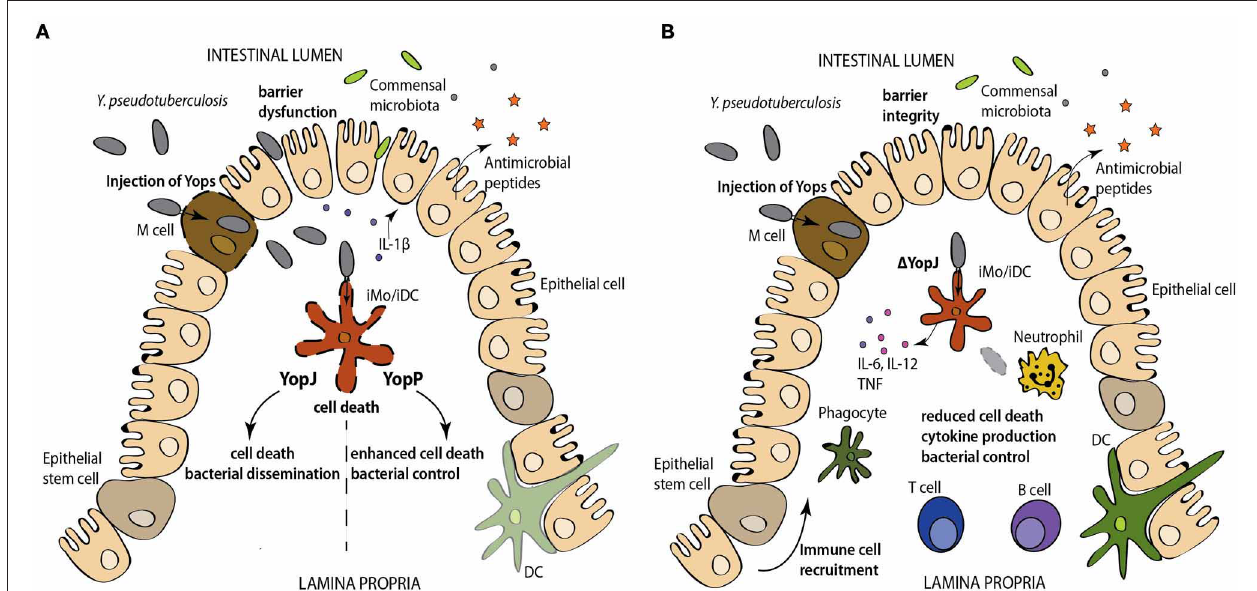
FIGURE 2 | (A) Injection of YopJ/P activates caspase-1 and the release of the caspase-1- dependent cytokines. However, the hypercytotoxic YopP-expressing Y. pseudotuberculosis induces enhanced levels of cell death and promotes bacterial control, relative to infection with YopJ-expressing Y.